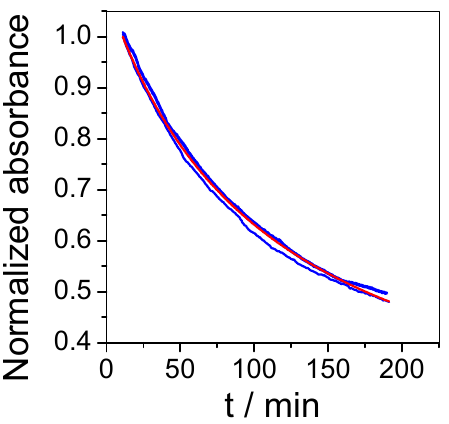
Figure 4. Experimental (blue) and model (red) curves of the normalized absorbance as a function of time in the presence of 120 ppb for three sensors analyzed at Day 1, Day 2, and Day 50 (k 0 = 8.1 × 10 − 5 ppb − 1 min − 1 and A inf = 0.137 ± 0.003).